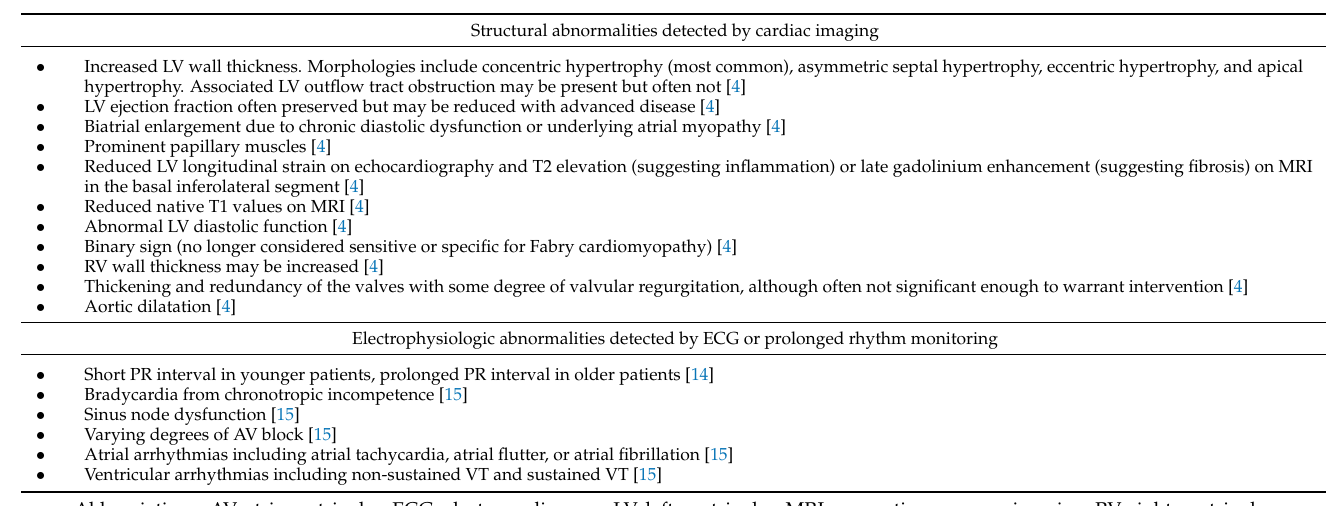
Table 1. Cardiac manifestations of Fabry